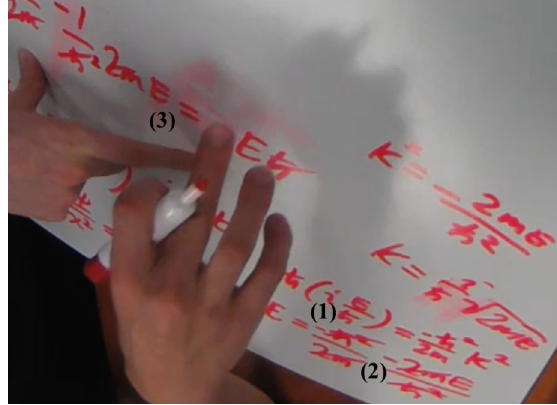
FIG. 2. Group problem solving in the algorithmic math frame.